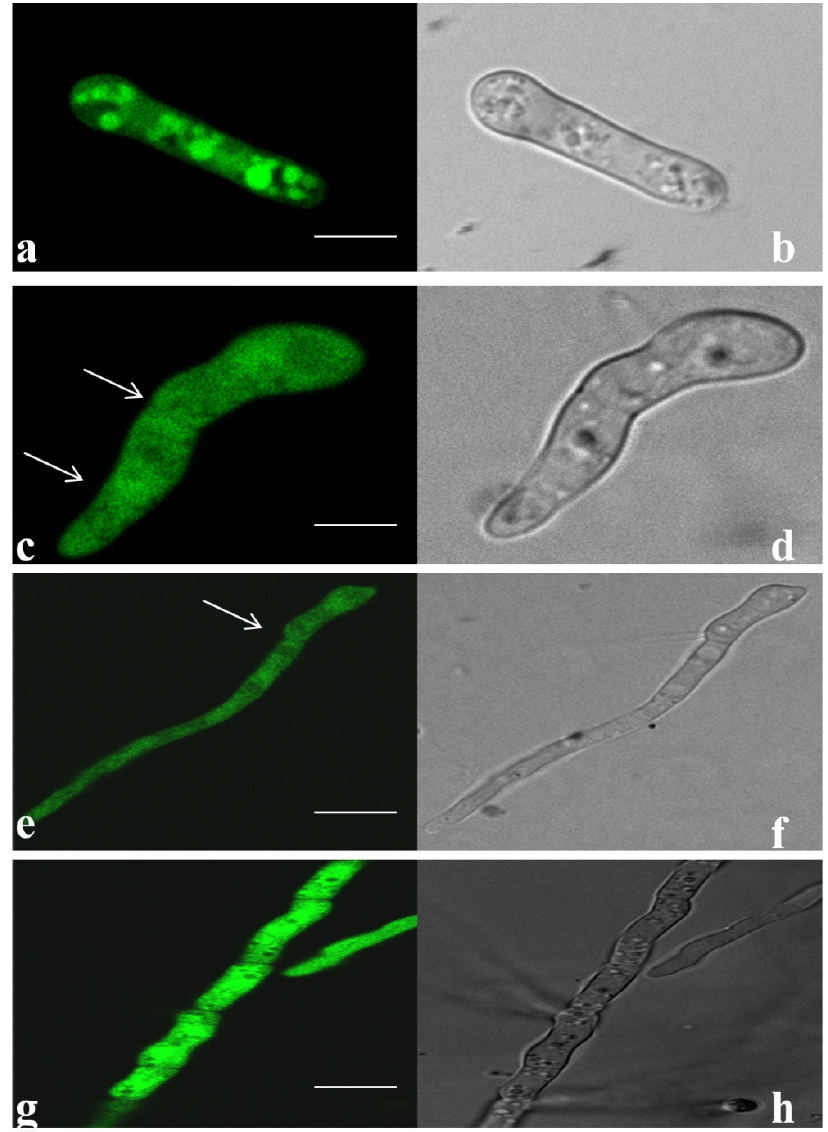
Figure 8. Expression of EGFP in transformed Fox R1. ( a , b ); Microconidia, ( c , d ); macroconidia, ( e , f ); germinating macroconidia, ( g , h ); Fox R1 hyphae. Each bar represents 10 µm. ( b , d , f , h ) are the transmitted light images. Arrow indicates the septation in macrospores.